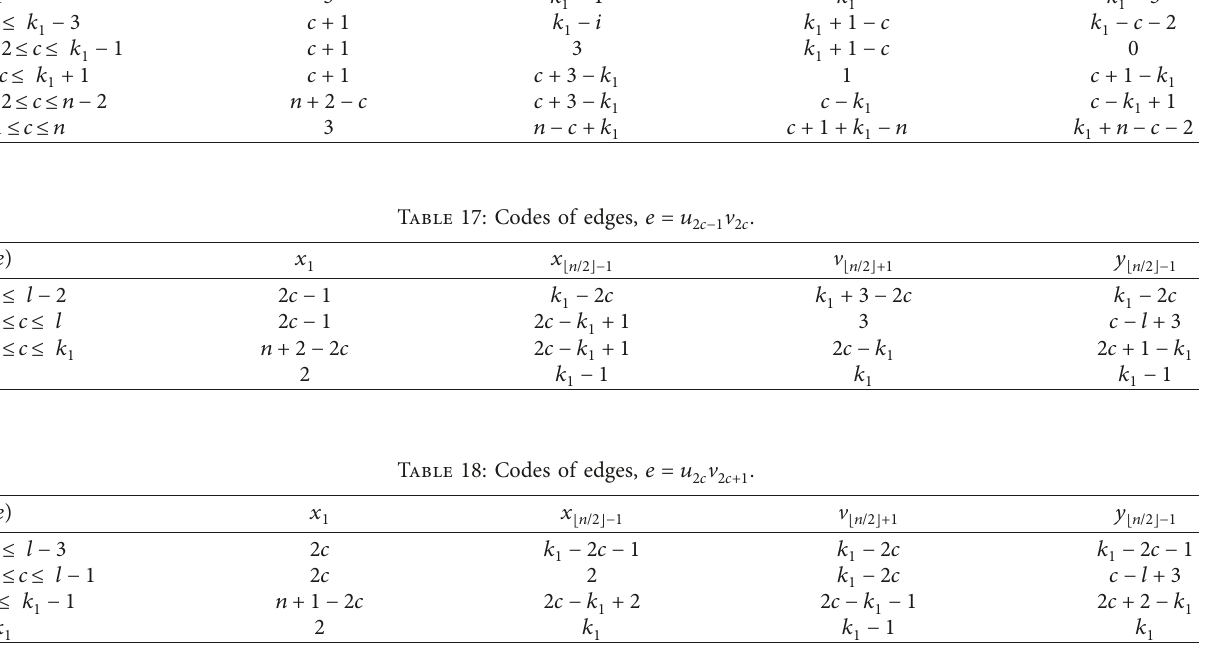
Table 16: Codes of edges, e � y